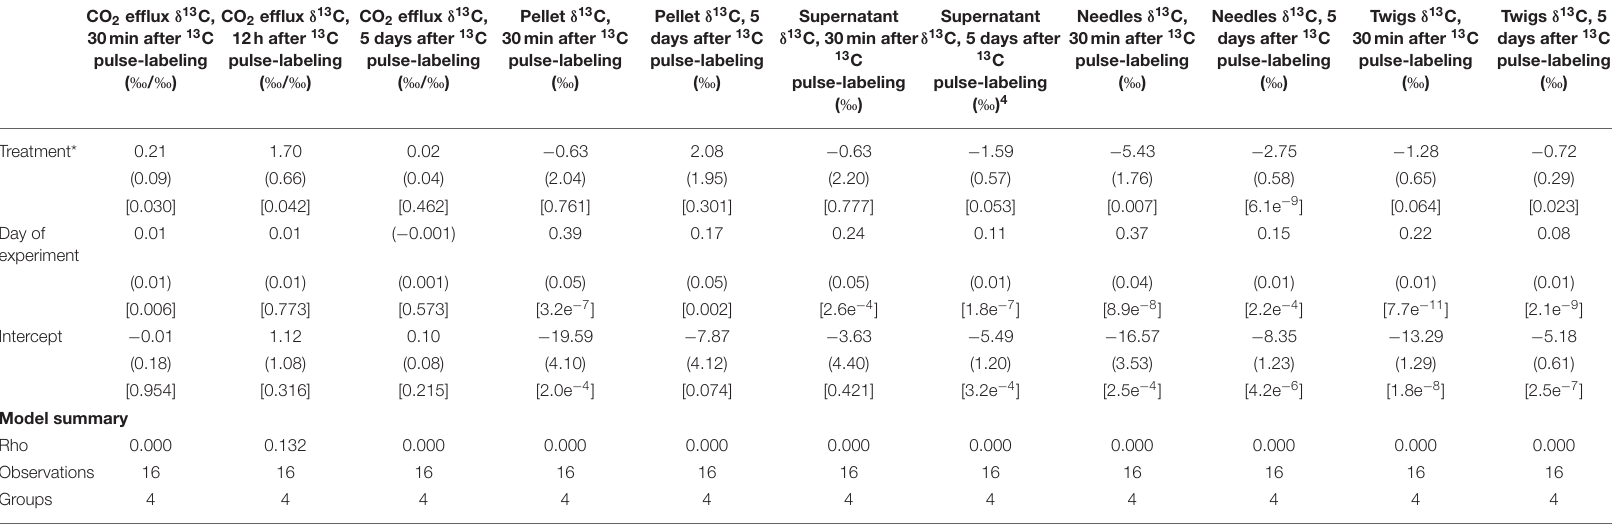
TABLE 3 | Summary of linear mixed models, quantifying effects of drought, and day of experiment of δ 13 C of respiratory CO 2 , soluble sugars (pellet and supernatant), needles, and twigs from current year developing shoots of black